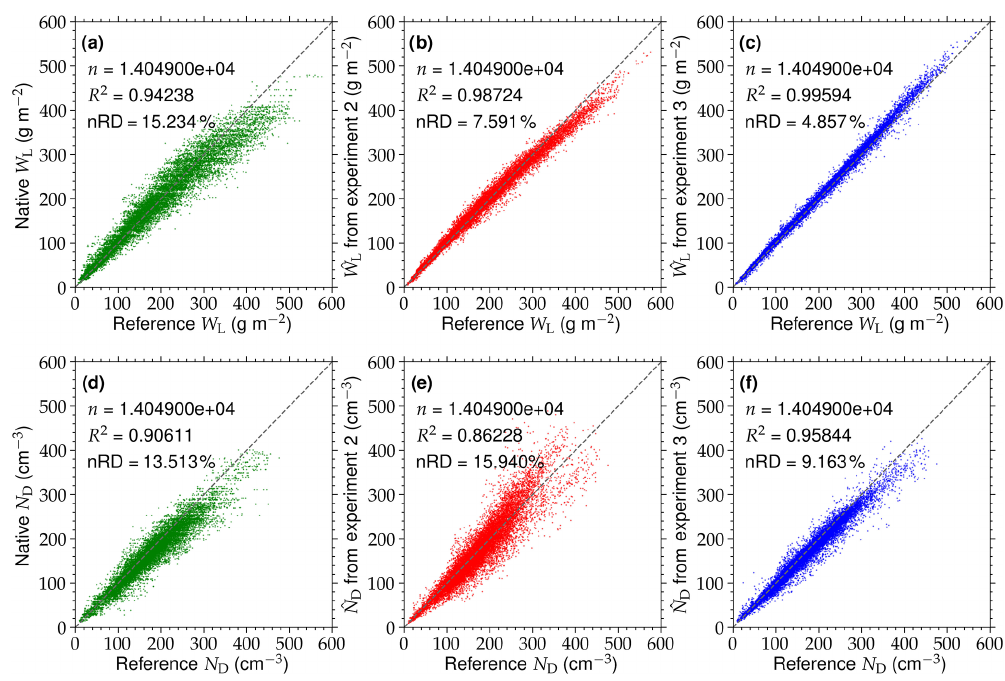
Figure 9. (a) Retrieved liquid water path ( W L ) at SEVIRI’s native LRES as a function of the reference results ( W L derived from the remapped MODIS reflectances at the HRES scale of ≈ 1km). Data are from example scene 2, sampled on 9 June 2013 at 10:55UTC. The dashed gray line represents the 1 : 1 line. The number of samples ( n ), explained variance ( R 2 ), and normalized root-mean-square deviation (nRD; defined as the RD between the two data sets, normalized by the average reference W L ) are given. (b) – (c) Same as (a) but for the comparison between reference W L and the downscaling results ( ˆ W L ) from experiments 2 (constant reflectance ratio approach) and 3 (adjusted lookup table approach with LUT slope adjustment), respectively. (d) – (f) Same as (a) – (c) but for the droplet number concentration ( N D and ˆ N D